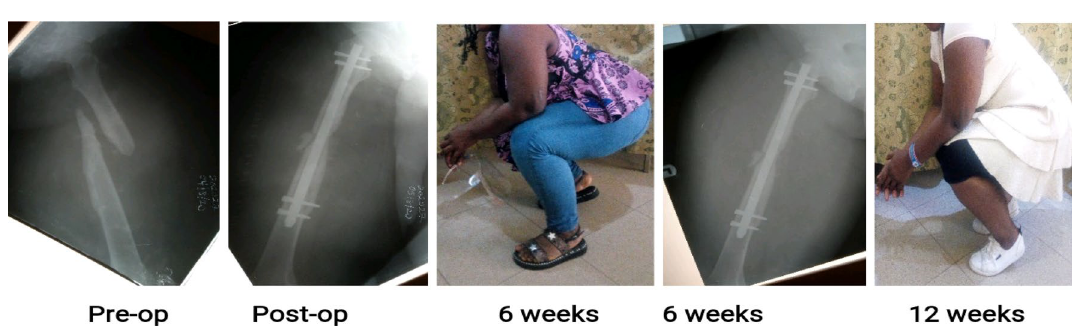
Figure 4. A 41-year old public servant with neglected atrophic non-union of a mid-shaft femur fracture fixed 92.8 months post-injury. She had walked with a limp and a stick before she had the fractured fixed, and was glad to return to work without the limp and the stick immediately after the 6th week follow-up visit, even without radiological